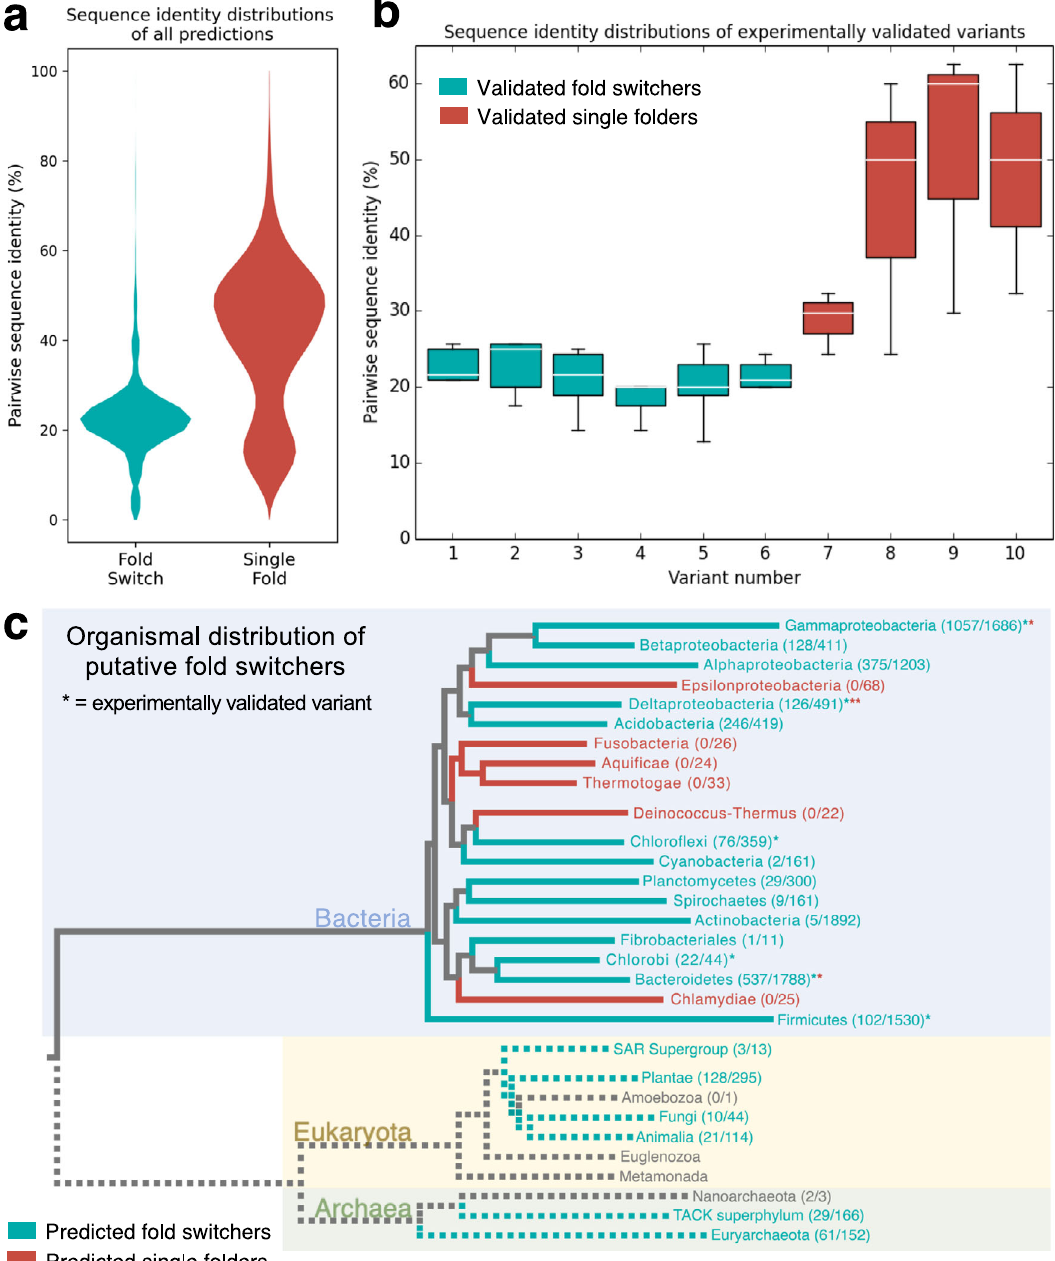
Fig. 4 The sequences of fold-switching CTDs are highly diverse and found in a wide variety of bacterial phyla. a Violin plots of pairwise sequence identities differ signi fi cantly for putative fold switchers and putative single folders. On average, pairwise sequence identities are lower for putative fold switchers (teal, 20.4%) than single folders (red, 40.5%). b Box-and-whiskers plots of pairwise sequence identities of fold-switching and single-folding CTDs of variants 1-10 in Fig. 2. The distributions of each teal (fold-switching)/red (single-fold) box were derived from n = 5/3 independent pairwise identities; each box bounds the interquartile range (IQR) of the data ( fi rst quartile, Q1 through third quartile, Q3); medians of each distribution are shown in white; lower whisker is the lowest datum above Q1-1.5*IQR; upper whisker is the highest datum below Q3 + 1.5*IQR. These distributions are consistent with the violin plots in panel ( a ). c Fold-switching CTDs are predicted in many bacterial phyla (blue background) and other kingdoms of life. Numbers next to taxa represent #predicted fold switchers/#total sequences. Gray branches represent unidenti fi ed common ancestors, since the evolution of fold- switching NusGs is unknown. Dotted lines represent lower-con fi dence predictions since fold switching has not been con fi rmed experimentally in Archaea (green background) and Eukaryota (yellow background). Fold-switching/single-folding predictions are represented by teal/red colorings; predictions in branches with fewer than 10 sequences are gray. Source data are provided as a Source Data fi backbone-to-sidechain hydrogen bond, 85% of residues in the contacts and one set each of interhelical contacts, strand-helix helix-loop interaction had a charged residue in one position (but contacts, and helix-capping contacts were observed (Fig. 3). not both), and 80% of residues in intrahelical contact a were both Overall, 96% of interhelical contacts were hydrophobic, 94% of hydrophobic. The remaining contacts gave more mixed results, helix-capping residues could potentially form an i-4 → i or i → i